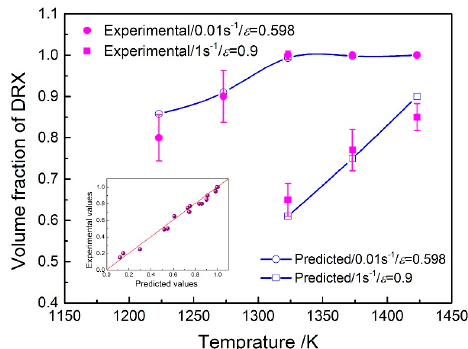
Figure 13. Comparisons between the predicted and experimental DRX volume fractions at strain rates of 0.01 s − 1 and 1 s − 1 . The inset figure is the correlation between the predicted and experimental ones for more working conditions.